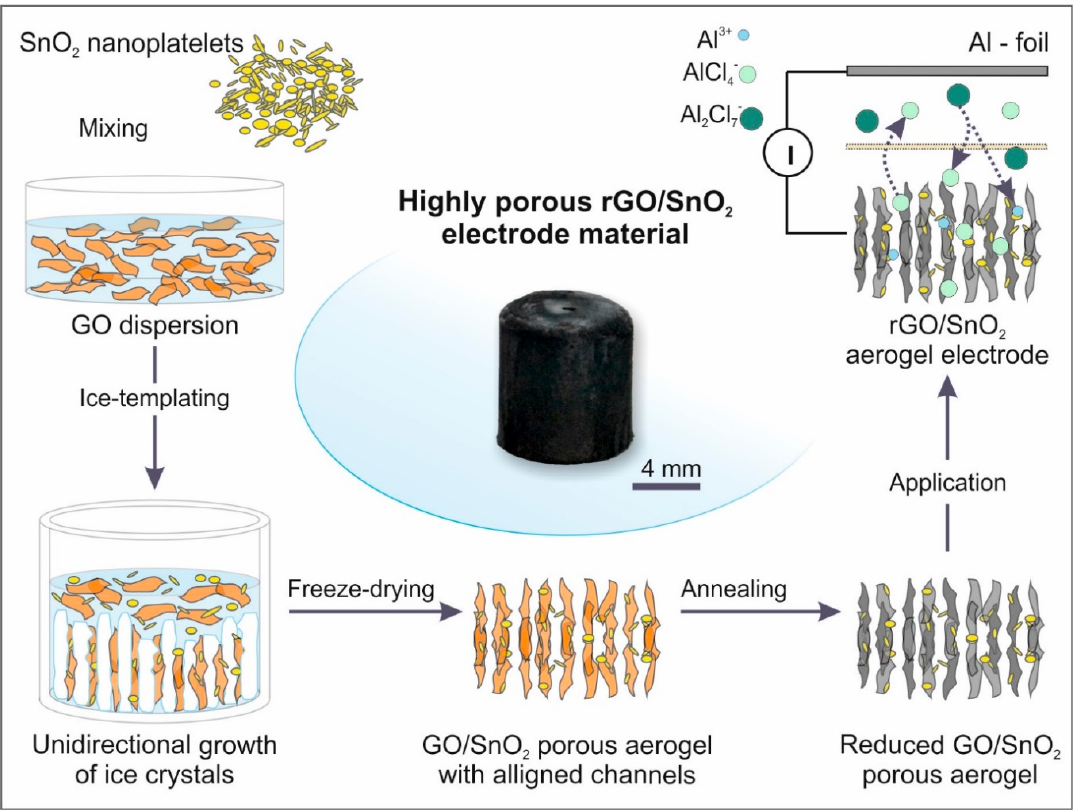
Figure 1. Schematic illustration of the fabrication process of free-standing highly porous rGO/SnO 2 aerogels and their application as a cathode material in AIBs.